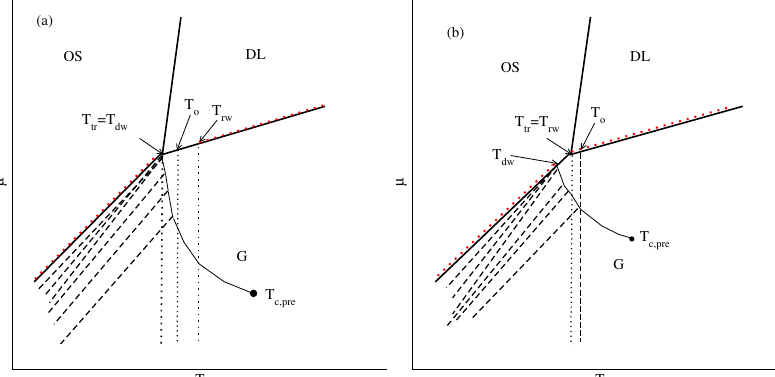
Figure 24. Schematic phase diagrams for the systems which exhibit the gas–liquid transition and order into the SAF ( a ) and AF ( b ) phase in the bulk. Thick solid lines mark the bulk phase boundaries between the gas (G), ordered solid (OS) and disordered liquid (DL) phases. The thick dashed lines mark layering transitions. The prewetting transition terminates at the critical point T c , pre . Red dotted lines along the bulk phase boundaries mark the regions of complete